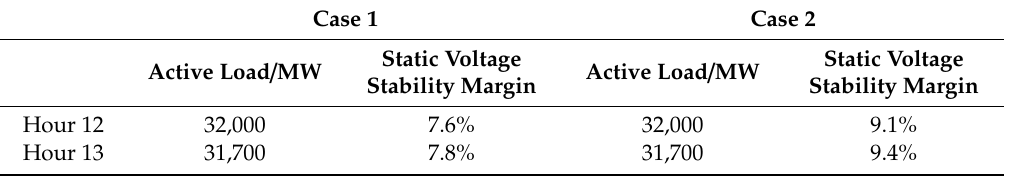
Table 4. Static voltage stability margin of the Sunan grid with the JINSU HVDC fed-in.